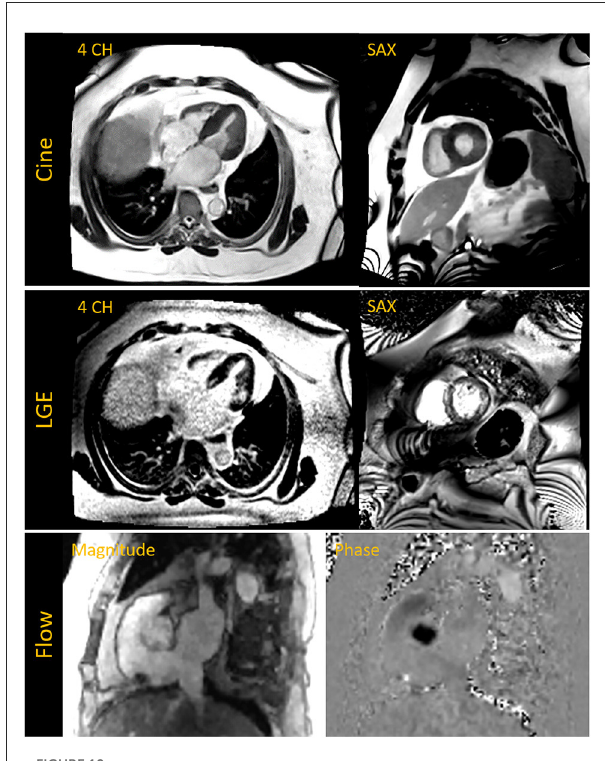
FIGURE10 The top row shows breath-held segmented compressed sensing (CS) based cine images acquired in the four chamber (4 CH) and short axis (SAX) view in a patient with a BMI of 57 kg/m 2 and who was previously unable to complete a cardiac MR exam on a 70cm bore system. Late gadolinium enhanced (LGE) images in the middle row depict fibrosis on the septum and lateral wall. The 4 CH was acquired with a free-breathing motion-corrected (MOCO) LGE sequence while the SAX image was acquired with a breath-held segmented method. The bottom row shows magnitude and phase images of the aortic root acquired with a CS based 2D phase contrast cine for flow